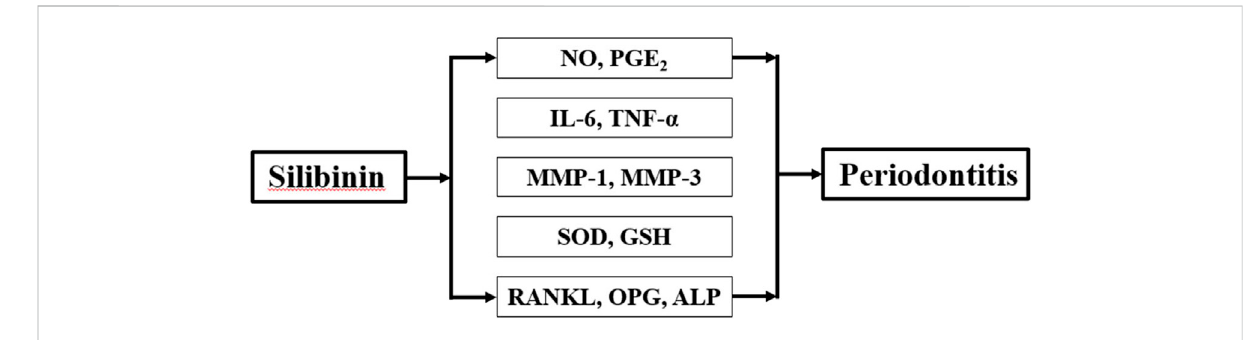
FIGURE 9 Effect of SB on LPS-induced